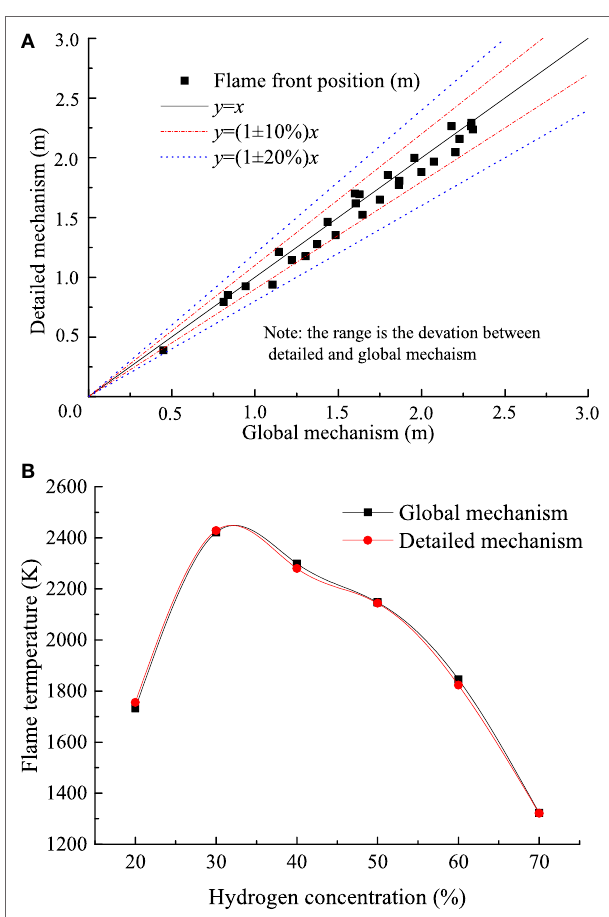
FIGURE 7 | (A) Comparison between global mechanism and detailed mechanism; (B) flame temperatures calculated by global mechanism and detailed